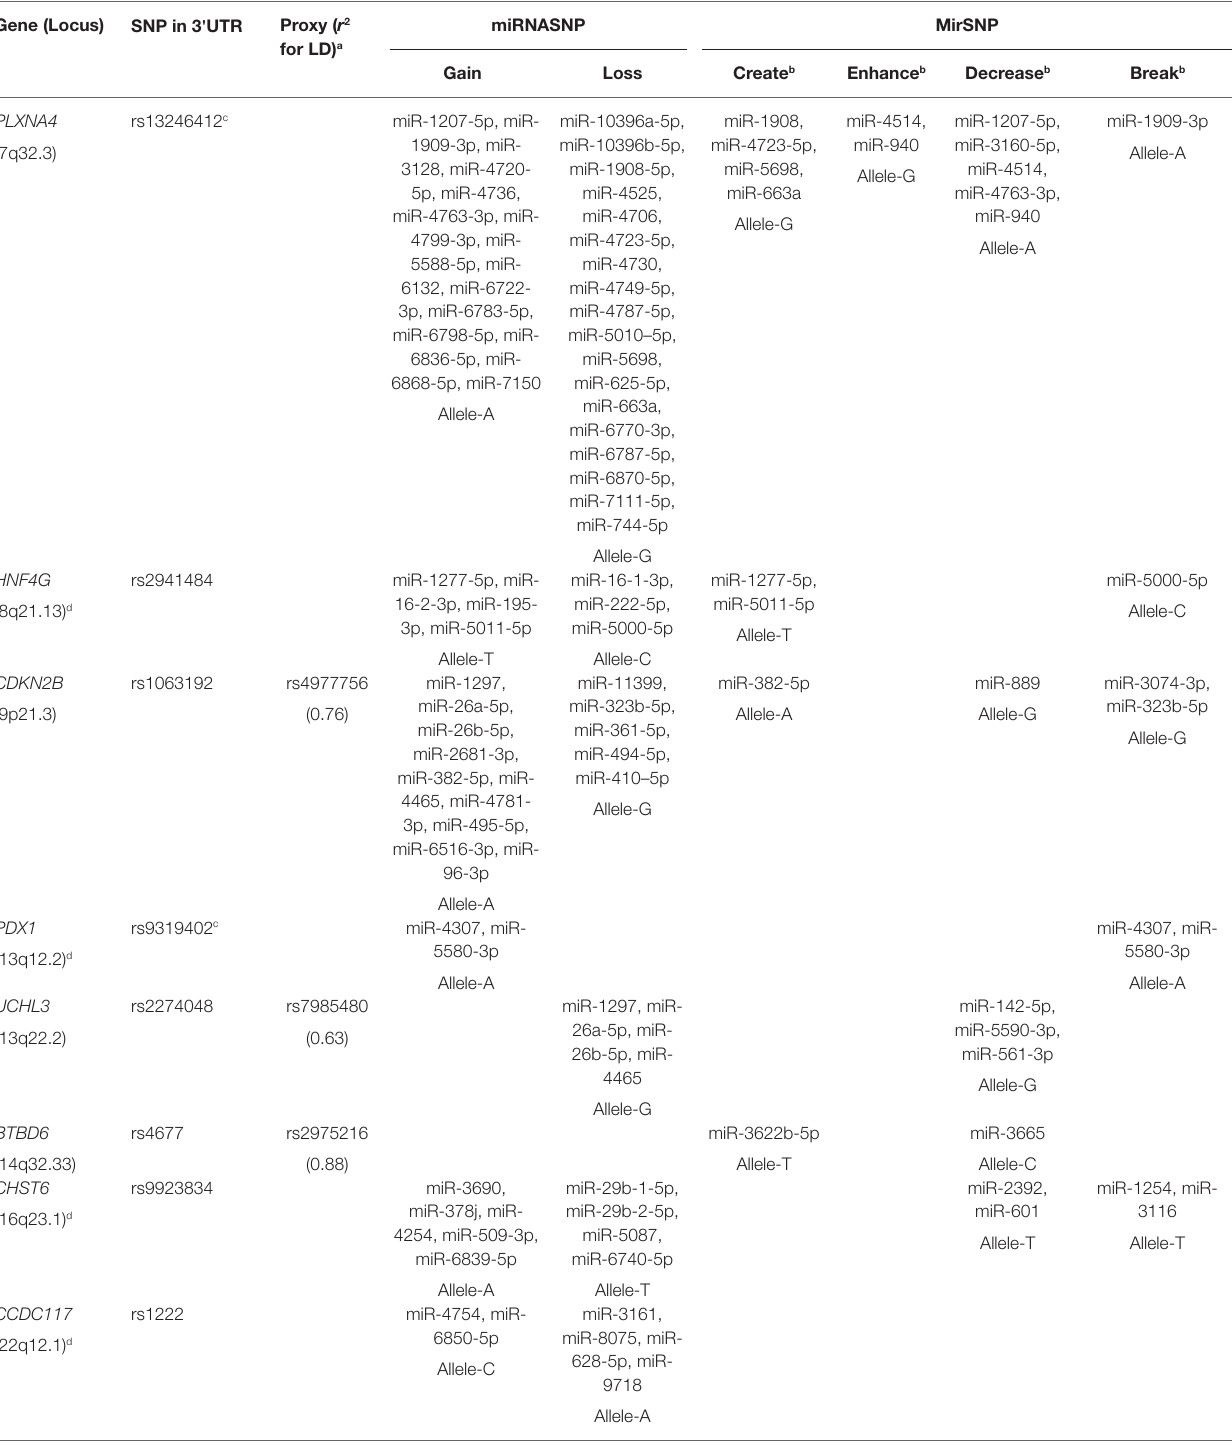
TABLE 2 | Effect of SNPs on miRNA binding using miRNA target prediction databases. Gene (Locus) SNP in 3 ' UTR Proxy ( r 2 miRNASNP MirSNP for LD) a Gain Loss Create b Enhance b Decrease b Break